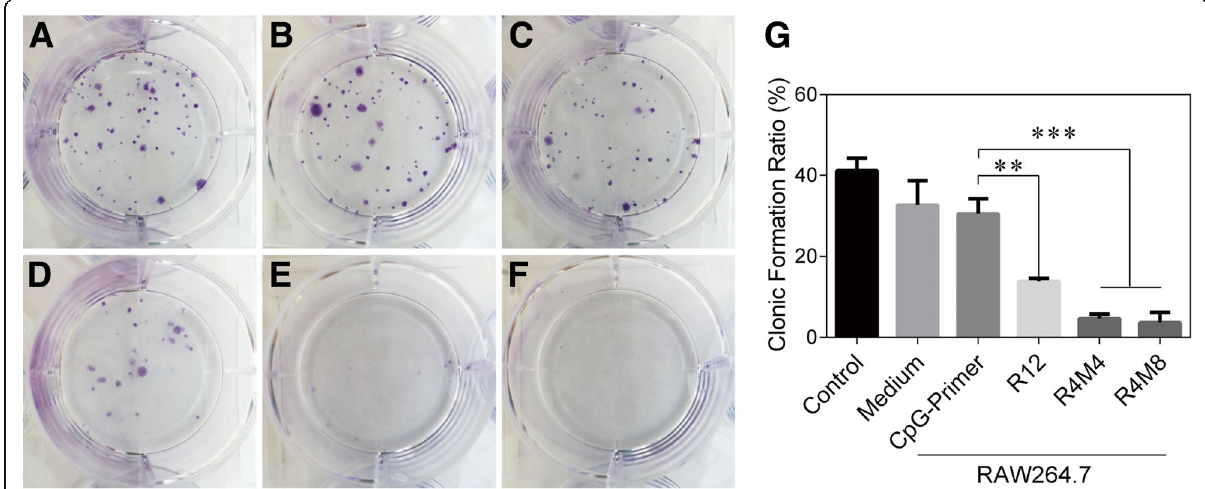
Fig. 5 The assessment on the therapeutic effect of immunostimulatory CpG-RCA gel (R12) and CpG-MCA gels (R4M4 and R4M8) on cancer cells in vitro by plate clone formation assay. U251 cells treated with a none, b RAW264.7 cells, c RAW264.7 cells treated with CpG-ODN, d RAW264.7 cells treated with R12, e RAW264.7 cells treated with R4M4, and f RAW264.7 cells treated with R4M8. g Results of the proliferation percentage of U251 cells after co-cultured with RAW264.7 cells for 24 h. Results are expressed as the mean ± SD of three independent experiments. ** P < 0.01, *** P <